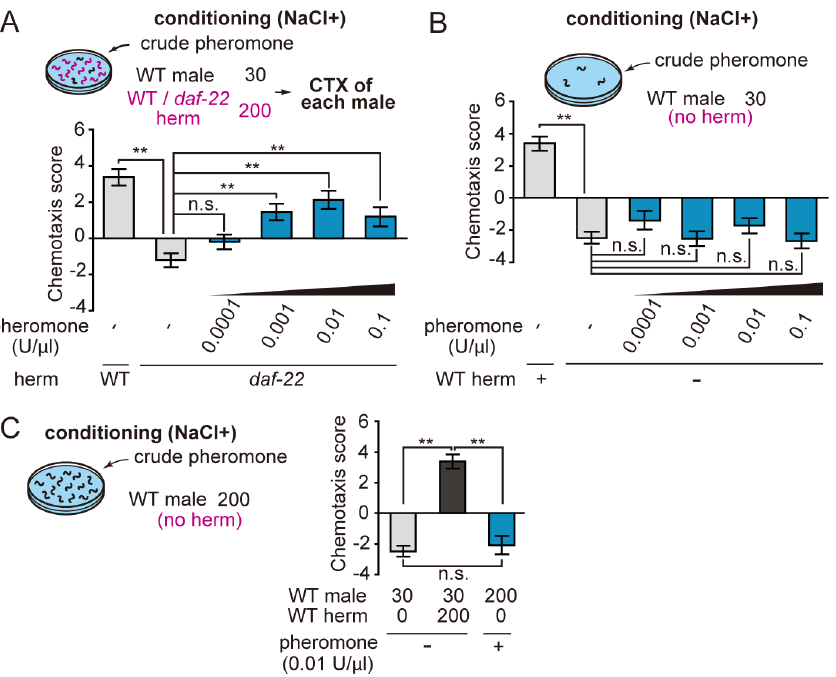
Figure 3. Pheromonal signaling is essential but not sufficient for sexual conditioning. (A) The daf-22(m130) hermaphrodite ( daf-22 herm) shows defects in sexual conditioning, which are rescued by addition of crude pheromone to the conditioning plate. Pheromone rescues sexual conditioning in daf-22 hermaphrodites **, P , 0.001; + , P , 0.05; n.s., not significant. Error bars represent SEM. n=18–36 animals. (B) Crude pheromone did not support sexual conditioning when applied without the daf-22 hermaphrodite. (C) Sexual conditioning does not occur on the pheromone- containing plate with a high-density population of males. **, P , 0.001; n.s., not significant. Error bars represent SEM. n=38–63 animals for each condition.